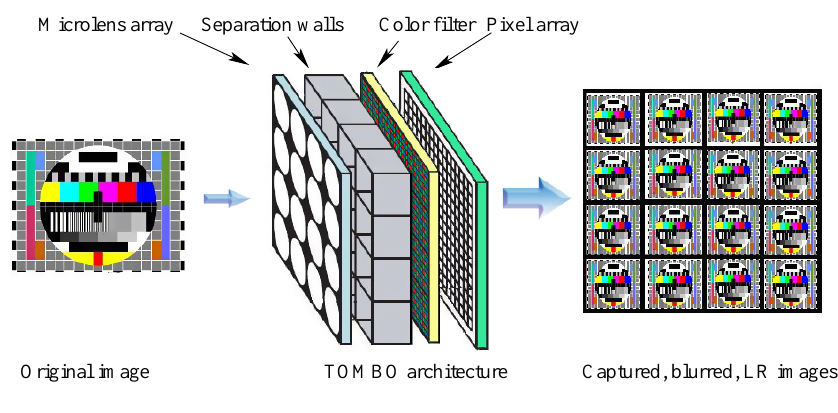
Figure 1. The architecture of a color TOMBO imaging